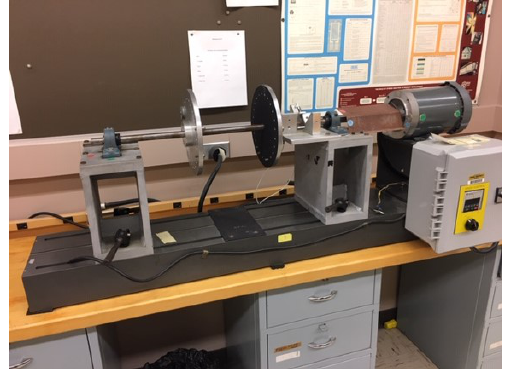
Figure 2. Motor Testbed.